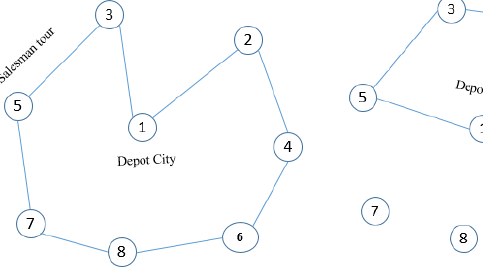
Fig. 3. An example solution of OTSSP with 6 k =